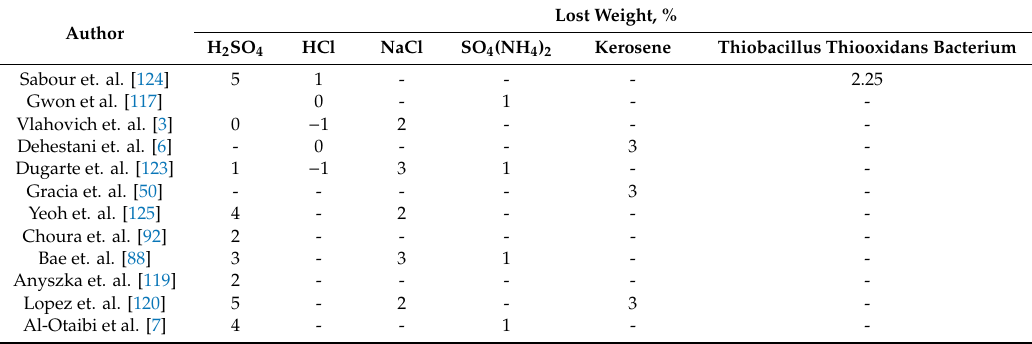
Table 7. Resistance of sulfur-based